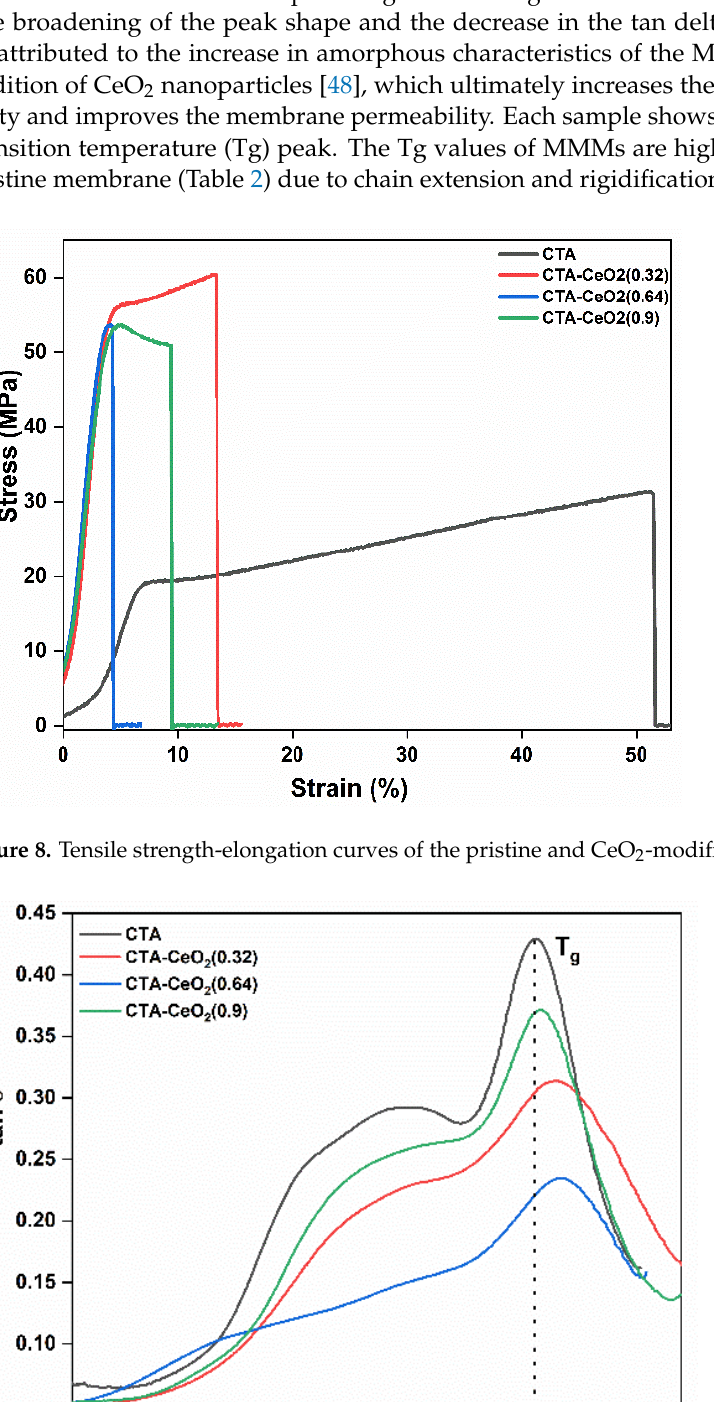
Figure 9. DMA plot showing the tan delta of pristine and CeO 2 -modified CTA membranes as a function of temperature.